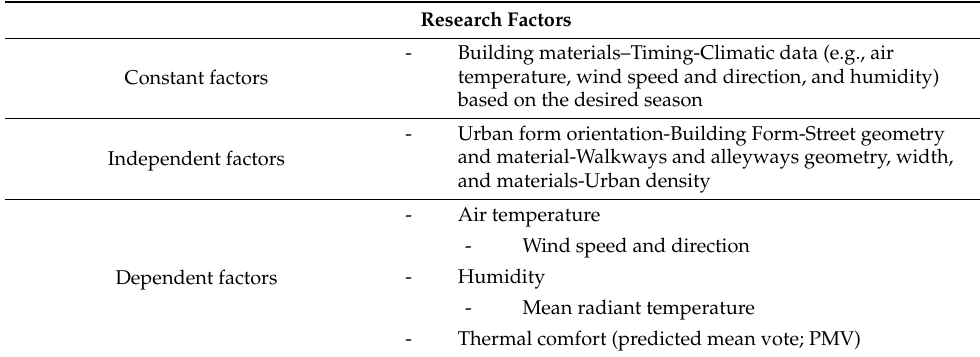
Table 3. Constant, independent, and dependent factors used in the simulation.